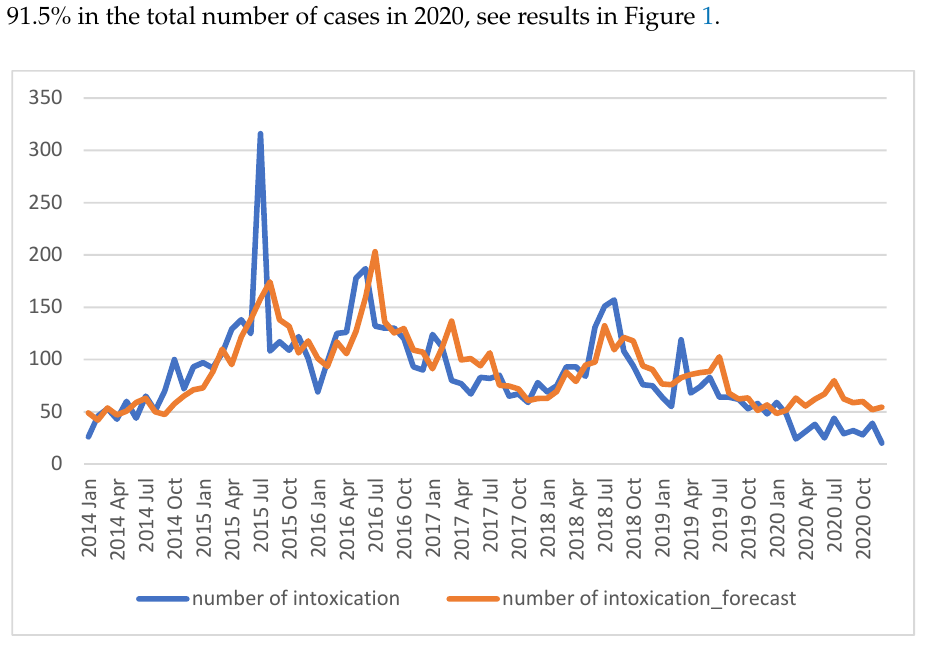
Figure 1. The number of intoxications and the number of intoxications forecasted over the years 2014–2020 using the Holt–Winters multiplicative seasonal method.